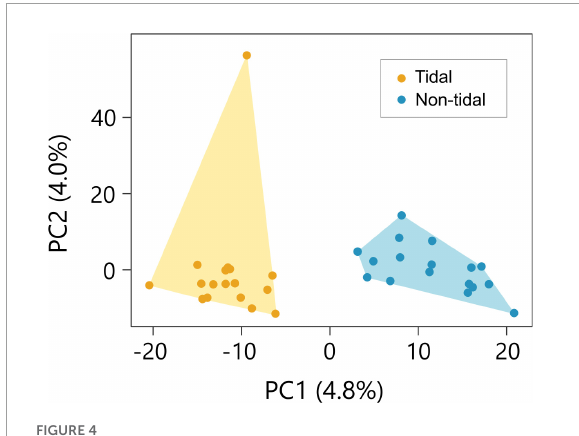
FIGURE4 Genetic structure of the non-tidal and tidal population. Samples collected in the tidal area and non-tidal area are shown in yellow and blue, respectively. Principal component analysis (PCA) on the non-tidal and tidal individuals. The two populations can be distinguished along the